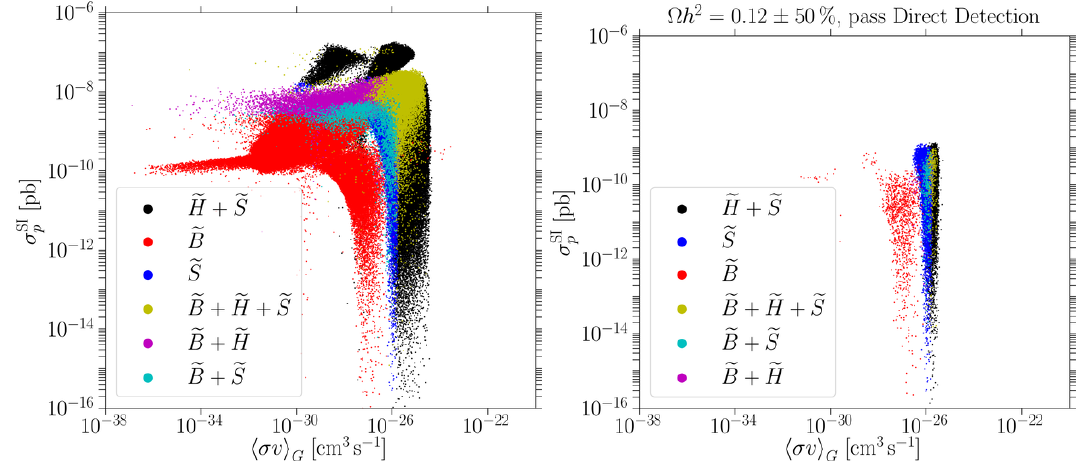
Figure 3 . SIDD cross section (cid:27) SI vs. the contribution of the longitudinal mode of the Z boson p (i.e. the Goldstone mode of the Higgs doublets) to the thermally averaged annihilation cross section as de(cid:12)ned in eq.(2.45) with the amplitude given in eq. (2.46). In the left panel, we show points from our parameter scan passing collider constraints, while points shown in the right panel are also required to have the correct relic density (cid:10) h 2 = 0 : 12 (cid:6) 50 % and satisfy bounds from direct detection experiments. The color coding indicates the compositions of the DM candidate as indicated in the (cid:21) 0 : 95, Higgsino e H if N 2 (cid:21) 0 : 95, or legend. We denote points as purely bino e B if N 2 + N 2 11 13 14